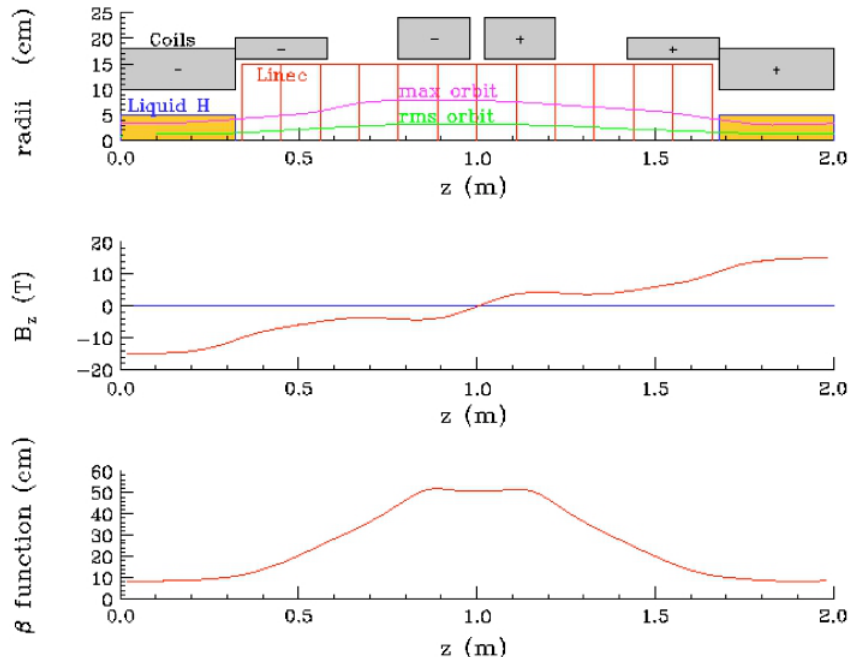
FIG. 24. (Color) (a) Cross section of one-half period of an alternating solenoid cooling lattice, (b) axial magnetic field vs z , and (c) b (cid:3) function vs z